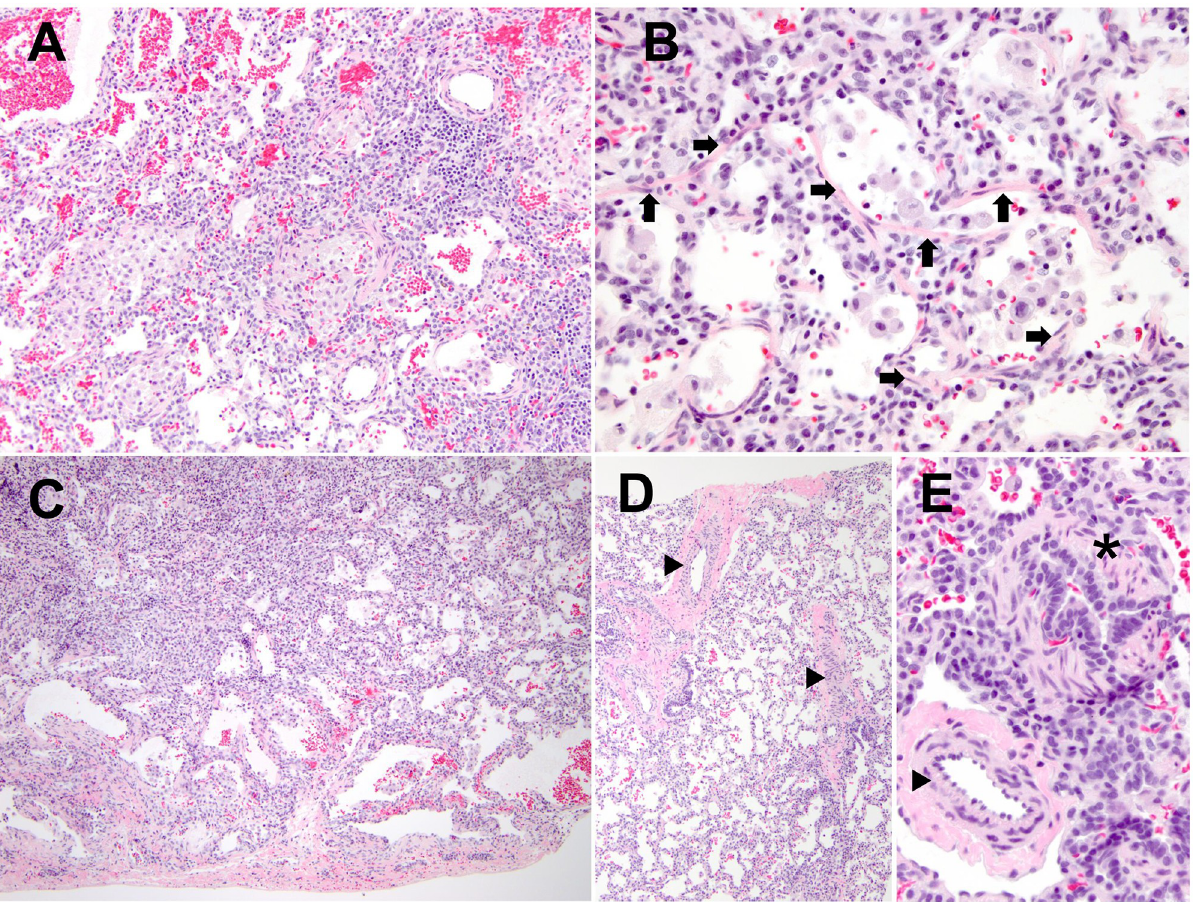
Fig 2. Pathological findings of the proband with homozygous ARHGAP42 stop-gain variant. Lung histologic findings at age 4 months, by hematoxylin and eosin stain: (A) Small airway obstructive-type changes, with prominent mural smooth muscle and intraluminal macrophages (original magnification, 200x); (B) Intra-alveolar septal extension of smooth muscle (arrows) (original magnification, 400x); (C) Large/maldeveloped airspaces, accentuated subpleurally (original magnification, 100x); (D) Concentric medial hypertrophy in pulmonary arteries (arrowheads) (original magnification, 100x); (E) Pulmonary artery (arrowheads) and airway (asterisk), both with prominent smooth muscle (original magnification,